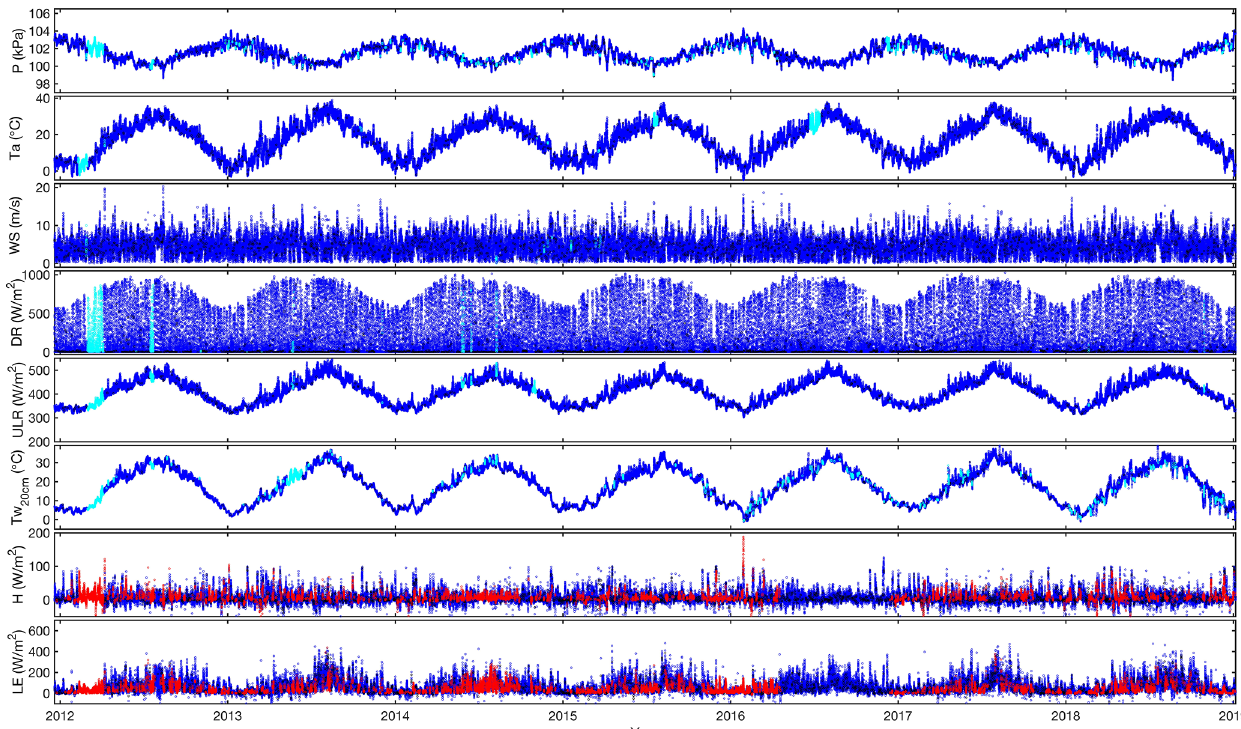
Figure 4. Complete gap-filled time series for selected variables observed at BFG. Blue, black, cyan and red dots represent quality flag 0, 1, 2 and 3, respectively. Variable definitions are given in Table